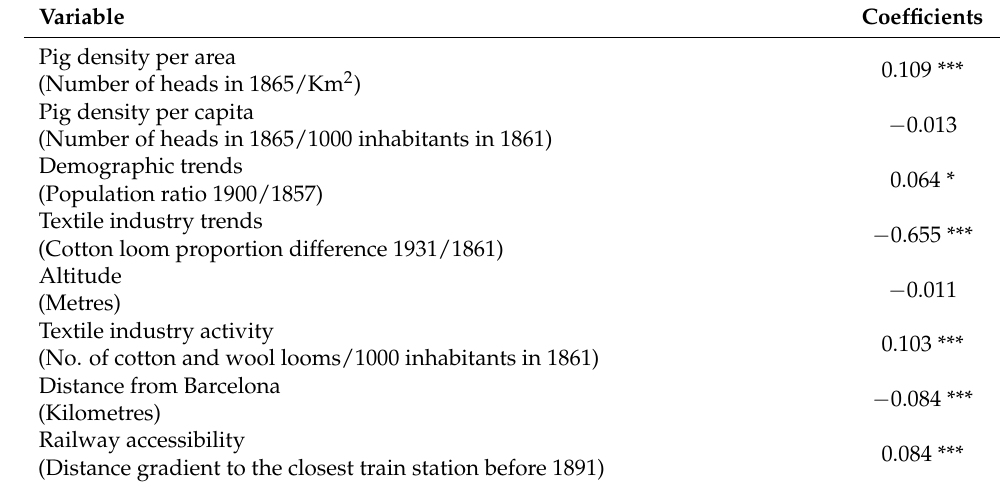
Table 1. Correlation between the municipal distribution of firms in 1896 and some potentially significant variables for determining the initial location of industrial pigmeat processing in late 19th-century